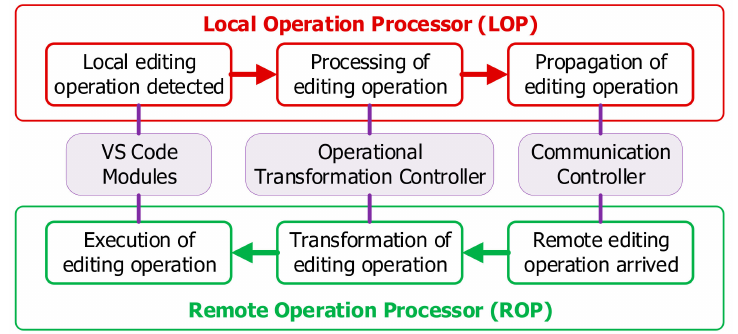
Figure 4. Local operation processor (LOP) and remote operation processor